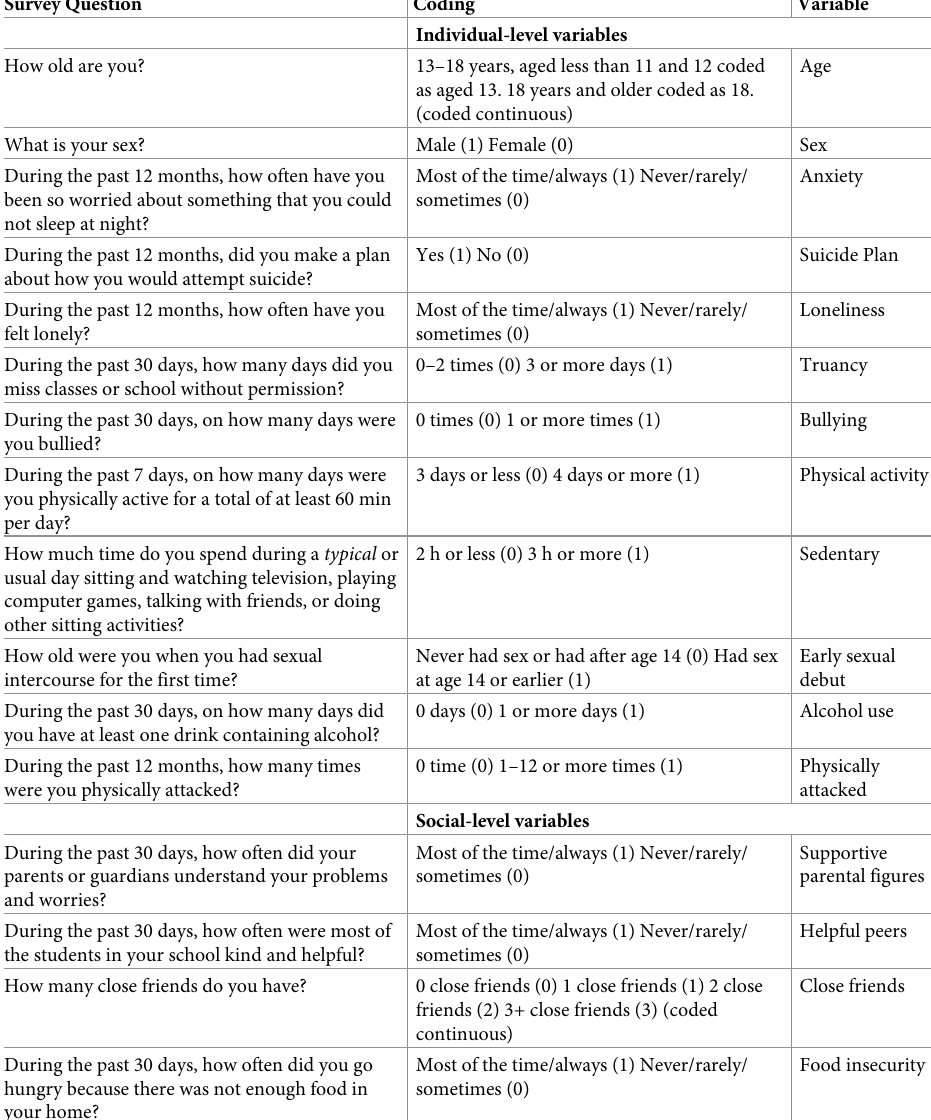
Table 1. Independent variable derivation from Paraguay GSHS survey data